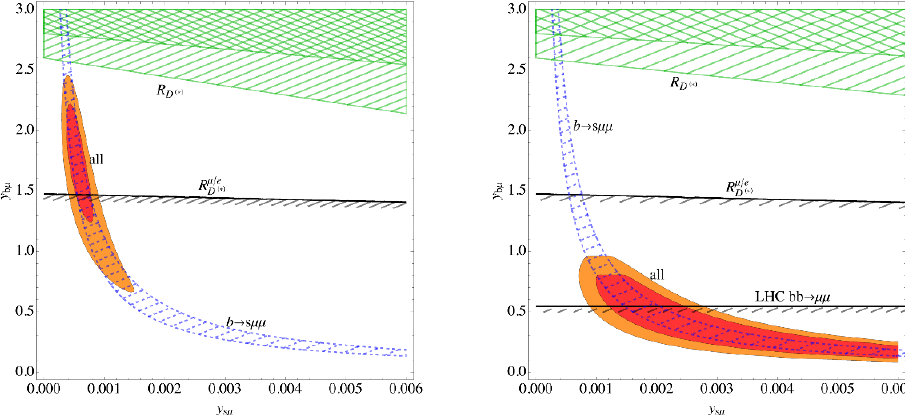
Figure 2 . Left panel: R is resolved in hatched (2 (cid:27) ) and doubly hatched (1 (cid:27) ) regions, whereas D ( (cid:3) ) the b ! s(cid:22)(cid:22) puzzle is resolved in dashed-hatched region at 1 (cid:27) . Region below the black line with a hatching is in 1 (cid:27) agreement with R (cid:22)=e . No LHC constraint on y b(cid:22) is considered. Right panel: D ( (cid:3) ) same as left panel apart from inclusion of constraint on y b(cid:22) from LHC. Red and orange regions in both graphs denote 1 (cid:27) and 2 (cid:27) results of the